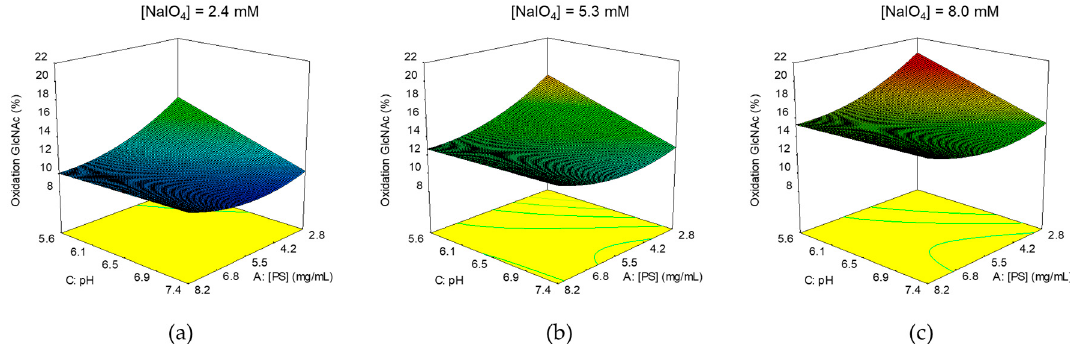
Figure 7. Identification of optimal conditions for GAC oxidation: 3D Surface Model Graphs for % GlcNAc oxidation response. Correlation between pH and GAC concentration at NaIO 4 concentration of 2.4 ( a ), 5.3 ( b ), 8.0 ( c ).